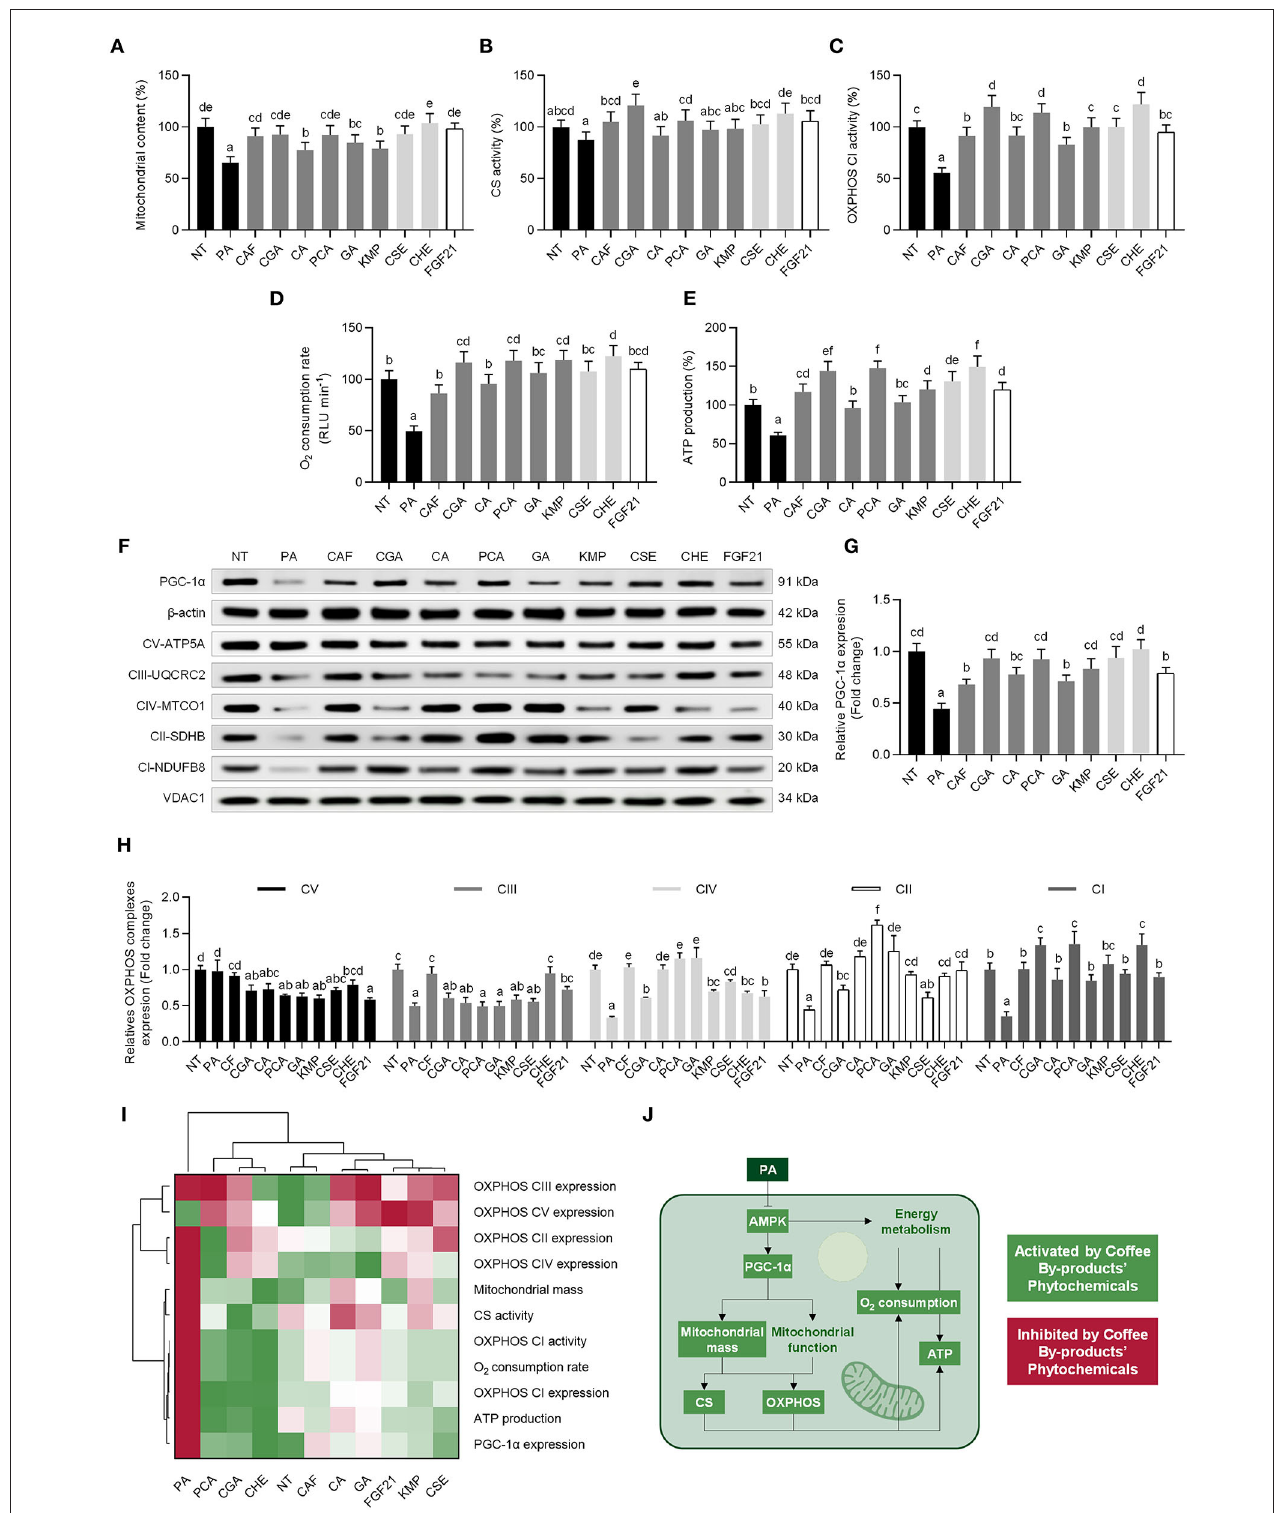
FIGURE 6 | Regulative role of standard solutions of the bioactive compounds from coffee by-products (50 µ mol L − 1 ), aqueous extracts (CSE and CHE, 100 µ g mL − 1 ), and FGF21 (20 nmol L − 1 ), in the presence of palmitic acid (500 µ mol L − 1 ) on the mitochondrial bioenergetics of HepG2 human hepatocytes.